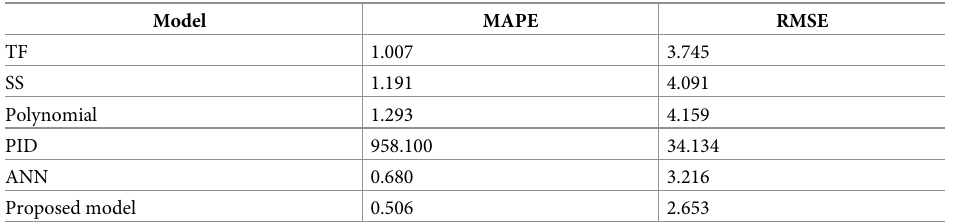
Table 6. Comparison between different cooler